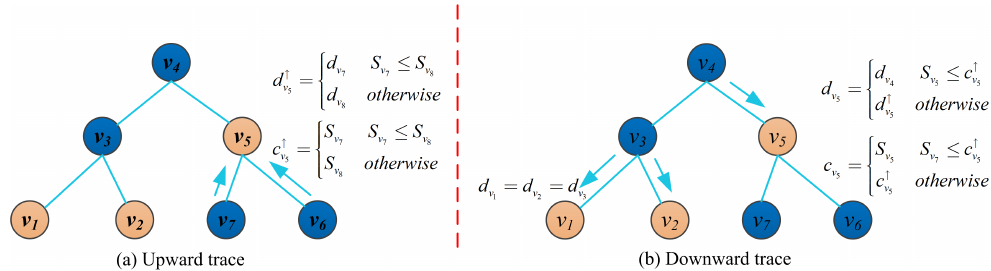
Figure 4. Stable disparities propagate along a minimum spanning tree. Blue and blown nodes correspond to stable and unstable pixels respectively. ( a ) Disparities of Stable pixels propagate from leaf nodes to root node. ( b ) Disparities of Stable pixels propagate from root node to leaf